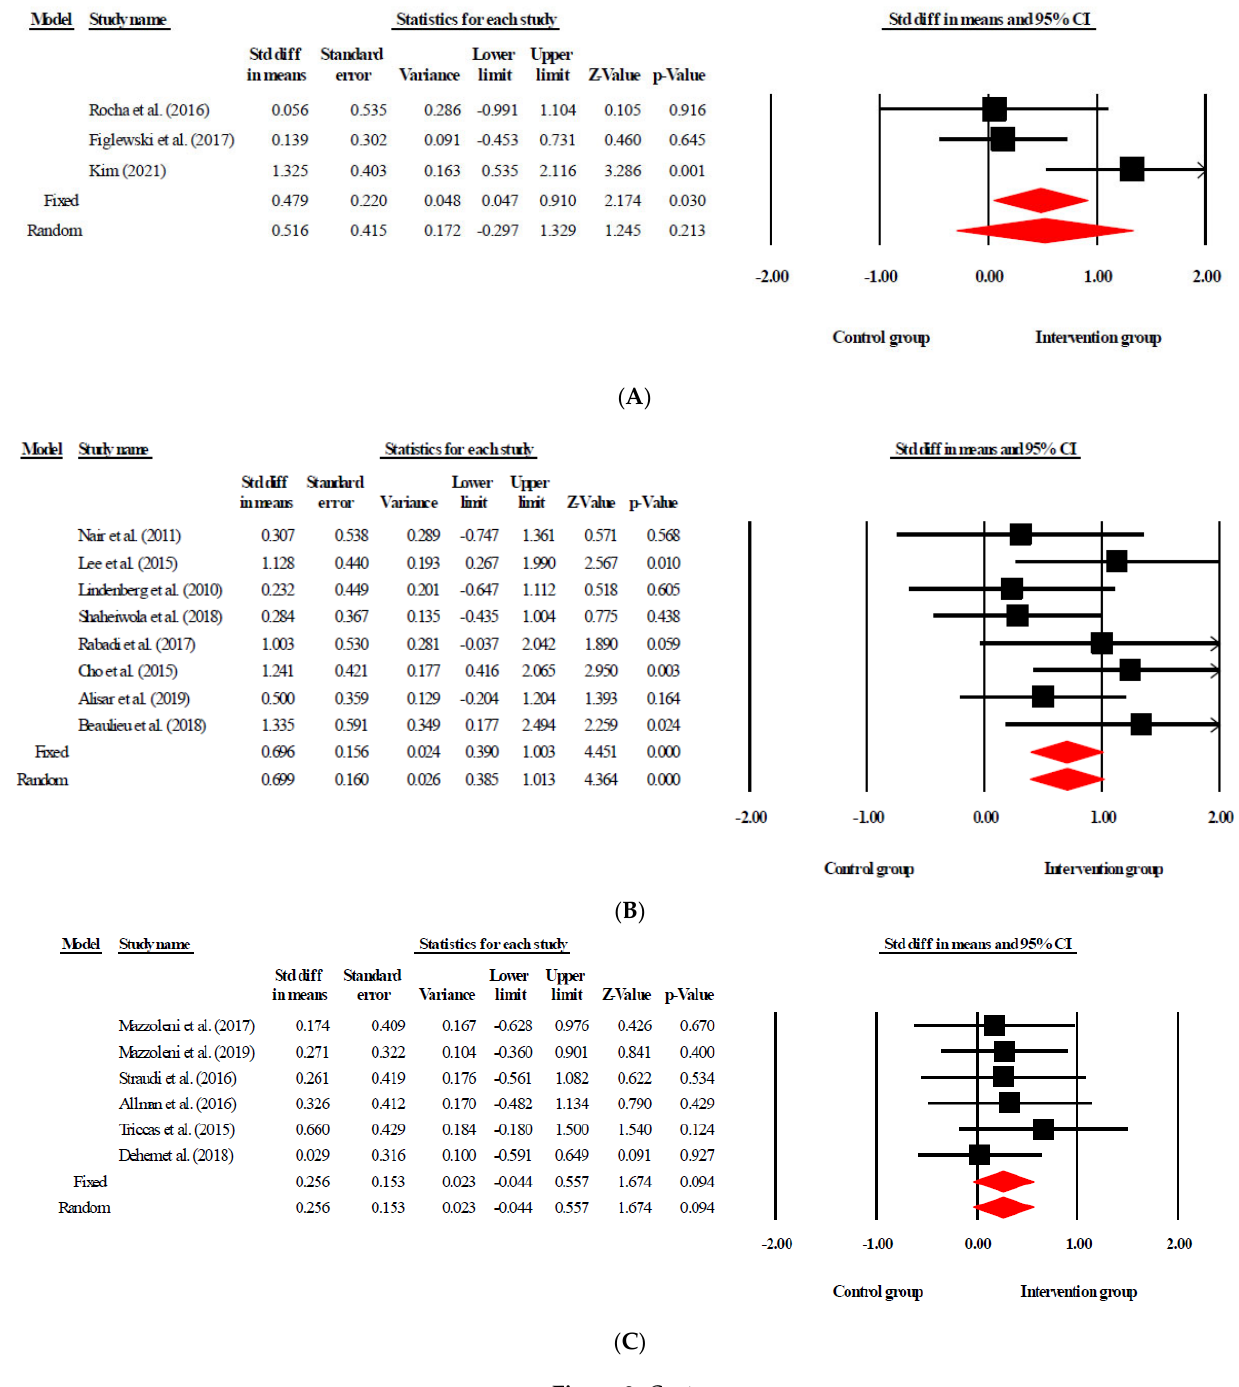
( D ) Figure 2. Forest plot showing the effect sizes for transcranial direct current stimulation combined with rehabilitation in stroke patients. ( A ): Constraint ‐ induced movement therapy. ( B ): Occupational therapy/physical therapy. ( C ): Robot ther ‐ apy. ( D ): Virtual reality therapy. Std diff: standard difference. Funnel plots of effect size against precision were used to investigate the presence of publication bias. The funnel plot was symmetrical across the center of the mean vertical axes of the funnel plot (Figure 3).